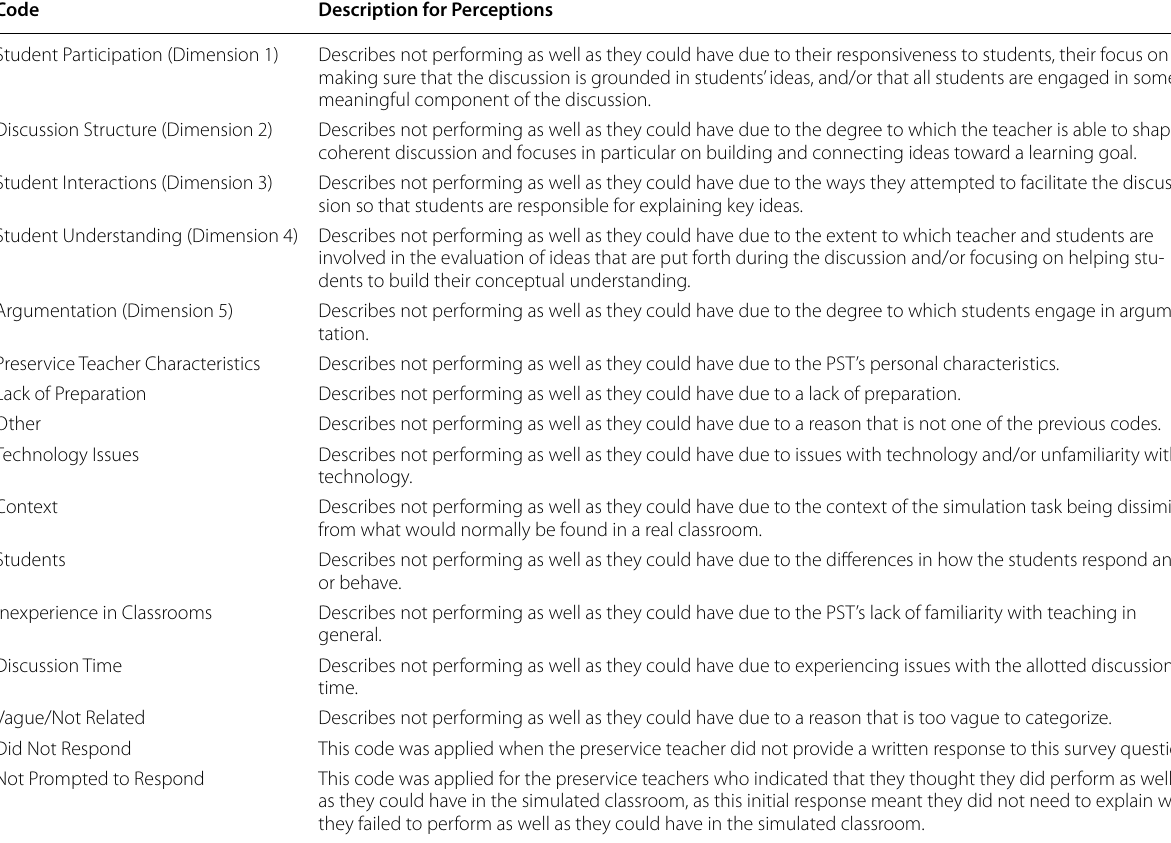
Table 4 Coding for Preservice Teachers’ Perceptions about Discussion Performance